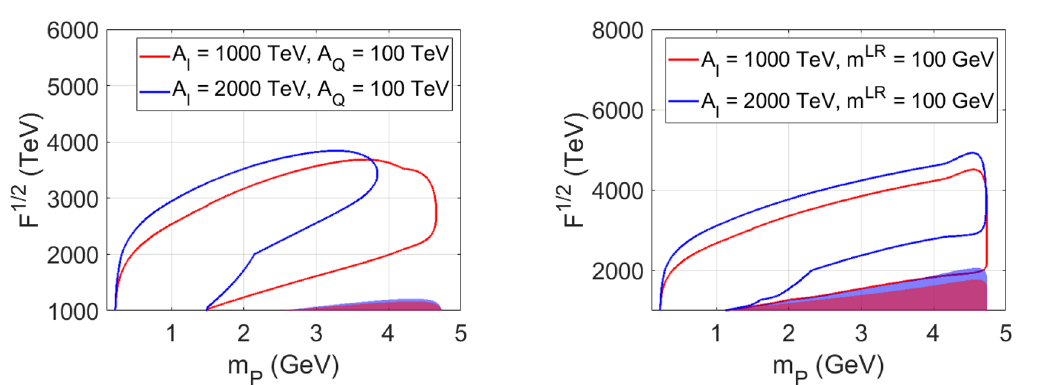
Figure 27 . Sensitivity region of FASER-II to models with sgoldstino flavor-conserving (left panel) and flavor-violating (right panel) couplings to quarks. Pseudoscalar sgoldstinos are produced in decays of beauty mesons and decay into lepton pairs. M 3 = 3 TeV. Shaded areas correspond to restrictions from table 1. In the regions where